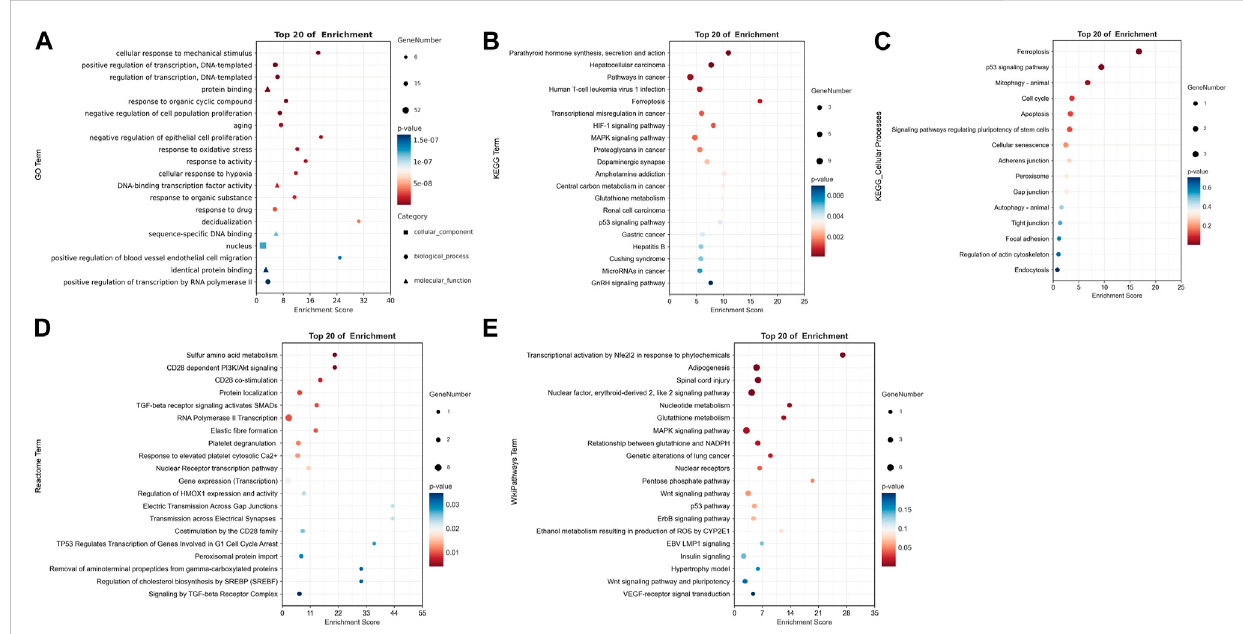
FIGURE 3 Representative results of functional enrichment analysis enriched by 52 DE-FRGs. (A) GO enrichment analysis. (B) KEGG pathway enrichment analysis. (C) Cellular processes inKEGG pathway enrichmentanalysis. (D) Reactome pathwayenrichmentanalysis. (E) WikiPathwaysenrichmentanalysis. A In GO term, bubbles with square, round, and triangle shapes stand for cellular component, biological process, and molecular function, respectively. (A – E) The size of the bubble shows the number of enriched genes. Red indicates smaller p -values and blue indicates larger p -values. All results satisfy p <